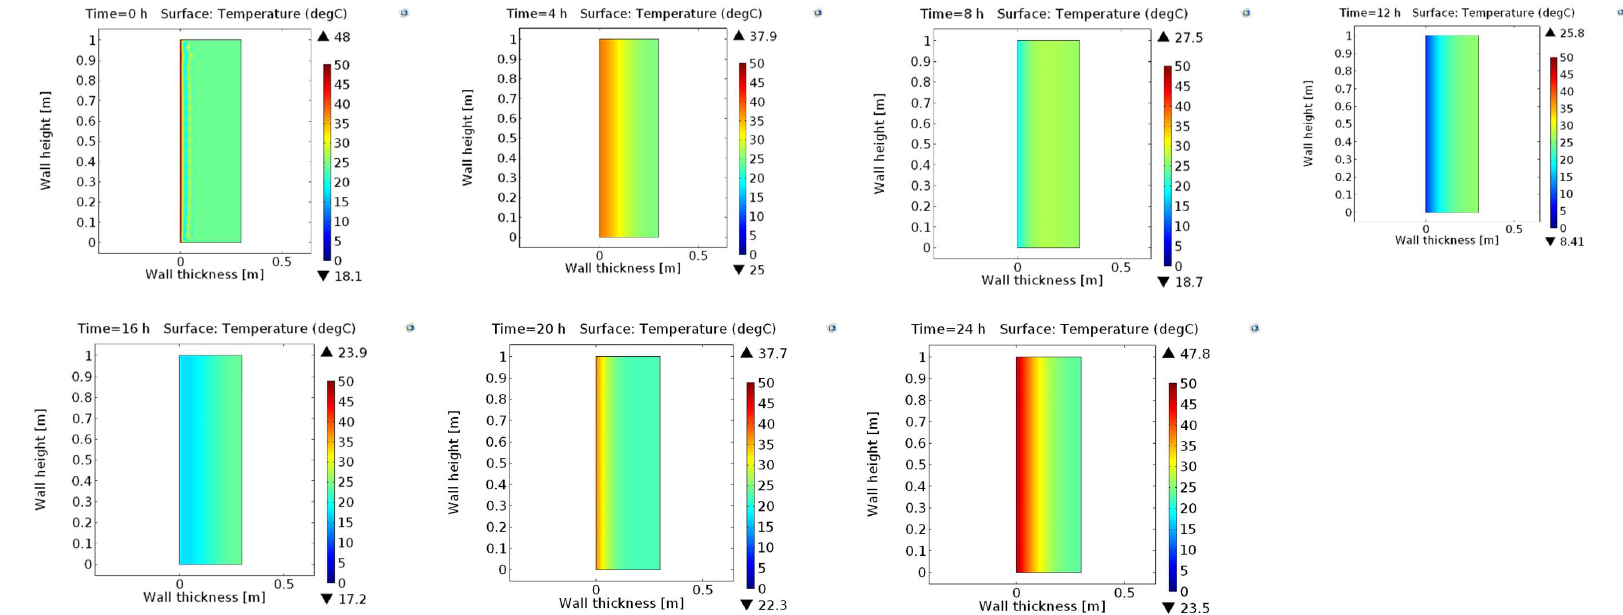
Figure 4. Two-dimensional (2D) temperature contours for a time period of 24 h (time step: 4 h) for the exposed wall of thermal conductivity of 1 W/m K in sunny spring conditions (SSE), using the sinusoidal function defined by the EN ISO 13786:2007 for the modeling of the external boundary conditions. Note: left-hand boundary of model: exterior wall surface; right-hand boundary of model: interior wall surface.